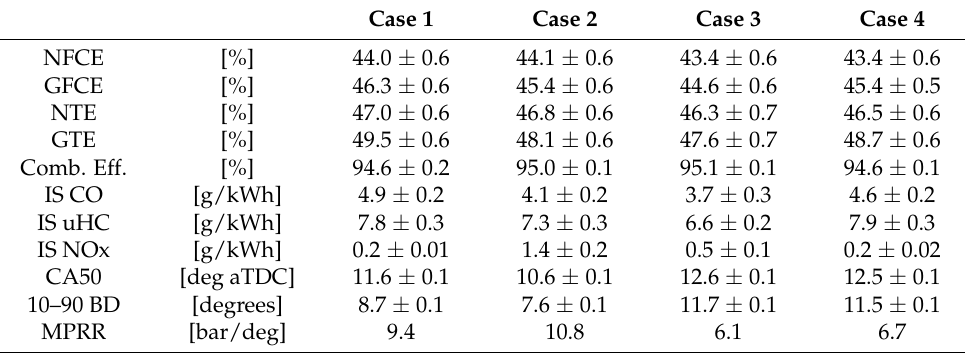
Table 3. Indicated performance and emissions results of a four-case